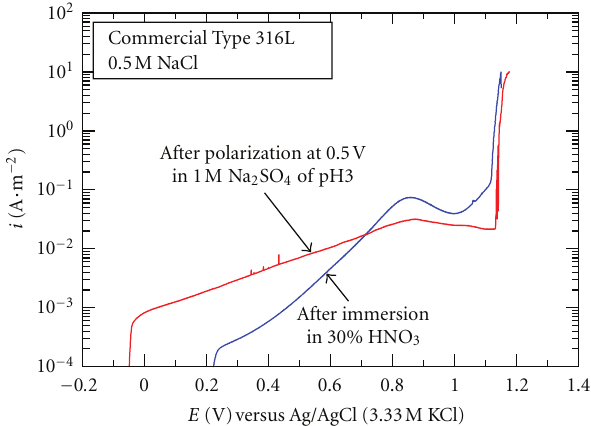
Figure 8: Anodic polarization curves in 0.5 M NaCl for commercial Type 316L stainless steels after passivation for 1h in 30% HNO 3 at 60 ◦ C and after polarization treatments at 0.5V for 30min in 1 M Na 2 SO 4 of pH 3.